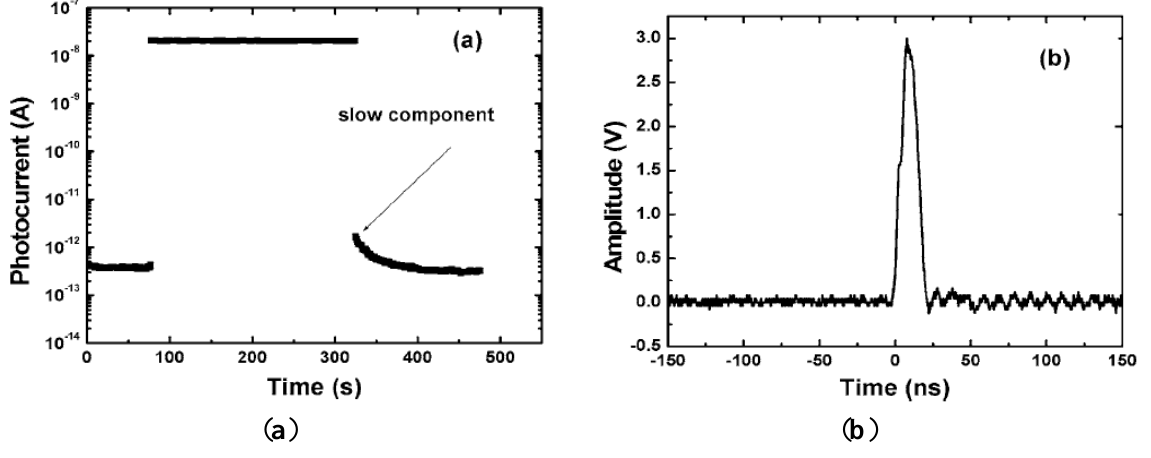
Figure 12. ( a ) Time response of the photoconductor upon 220 nm light illumination measured by a mechanical chopping method and ( b ) time-resolved photoresponse upon a 193 nm excimer laser recorded by an oscilloscope with a 50 Ω impedance (reprinted from Reference